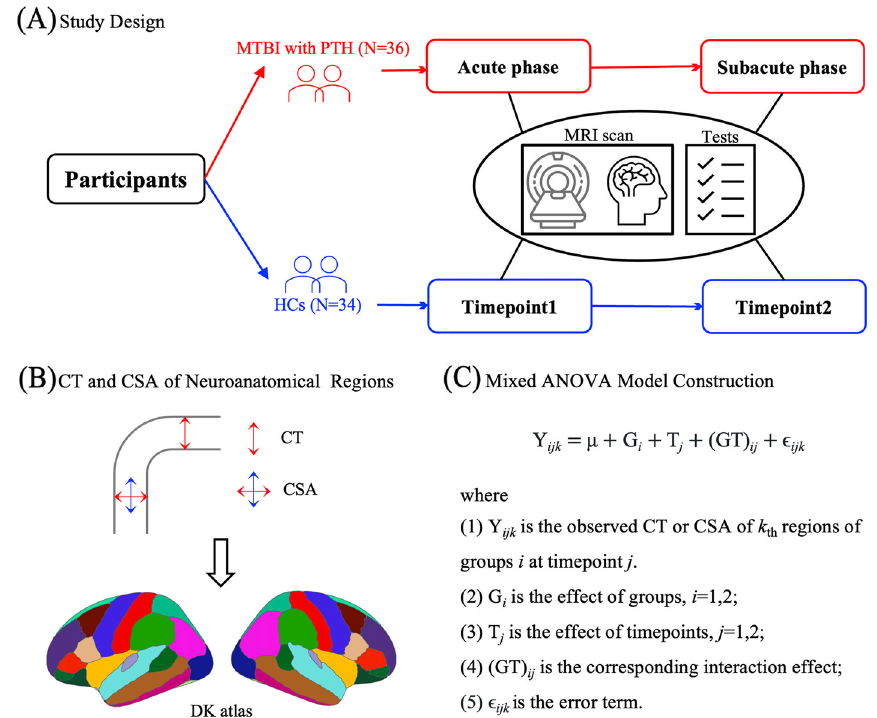
Fig. 1 Study design framework. A Participants recruited in this study. The MRI scanning and neuropsychological tests were performed at two timepoints for patients and matched HCs. B Construction of CT and CSA of cortical regions and defined by the Desikan atlas. C Mixed ANOVA model was conducted for CT and CSA of 68 bilateral cortical regions. MTBI, mild traumatic brain injury; PTH, posttraumatic headache; HCs, healthy controls; CT, cortical thickness; CSA, cortical surface area; ANOVA, analysis of